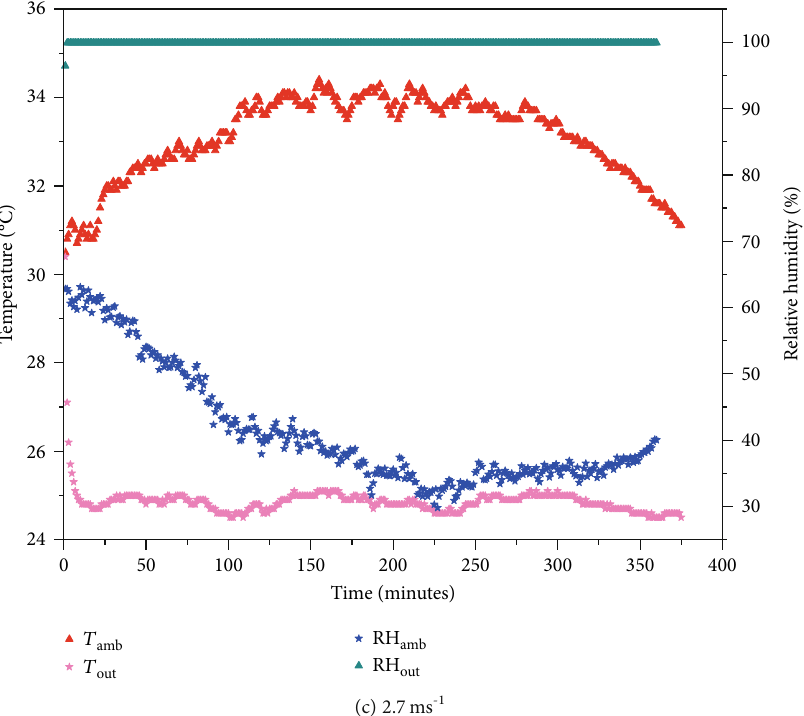
Figure 8: Temperature and RH variations of the air from the air cooler at three di ff erent velocities under medium RH